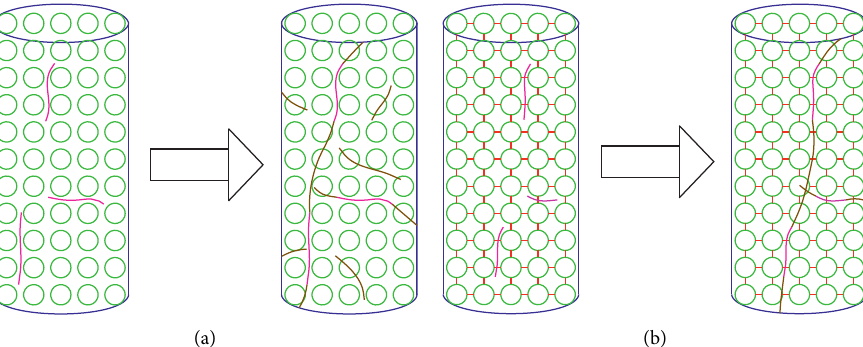
Figure 19: Instability mode of cement paste sample. (a) Dispersed load-bearing instability mode. (b) Cumulative load-bearing instability